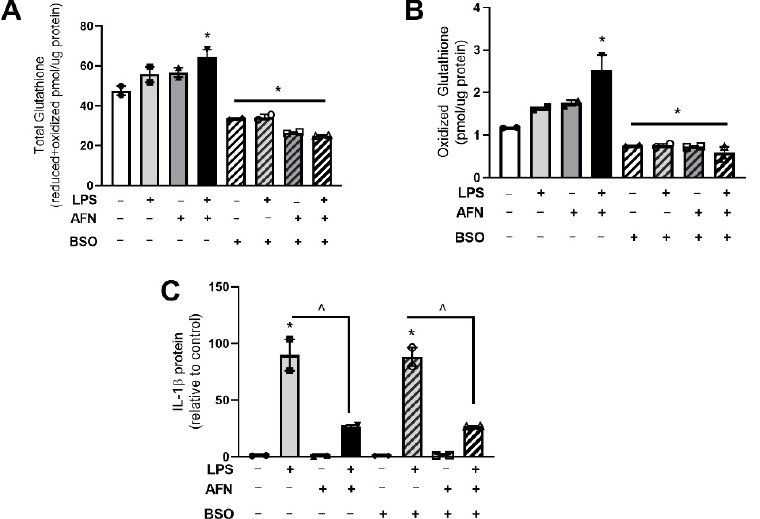
Figure 5. Total and oxidized glutathione are suppressed by BSO treatment with no effects on IL-1 β levels. ( A ) Total glutathione (reduced + oxidized), ( B ) oxidized glutathione, and ( C ) IL-1 β protein levels were measured in total cell homogenates at 6 h in LPS (0.05 mM)/BSO and AFN-treated MH-S cells as described in Methods. Solid bars indicate non-BSO treated controls, hatched bars indicate treatment with BSO. Data were analyzed by two-way ANOVA to identify the effects of LPS and/or AFN exposure. Tukey’s post-hoc analysis was used to determine significant differences between groups; n = 2 individual experiments. * p < 0.005 from control non-stimulated; ^ p < 0.005 LPS vs. LPS + AFN.